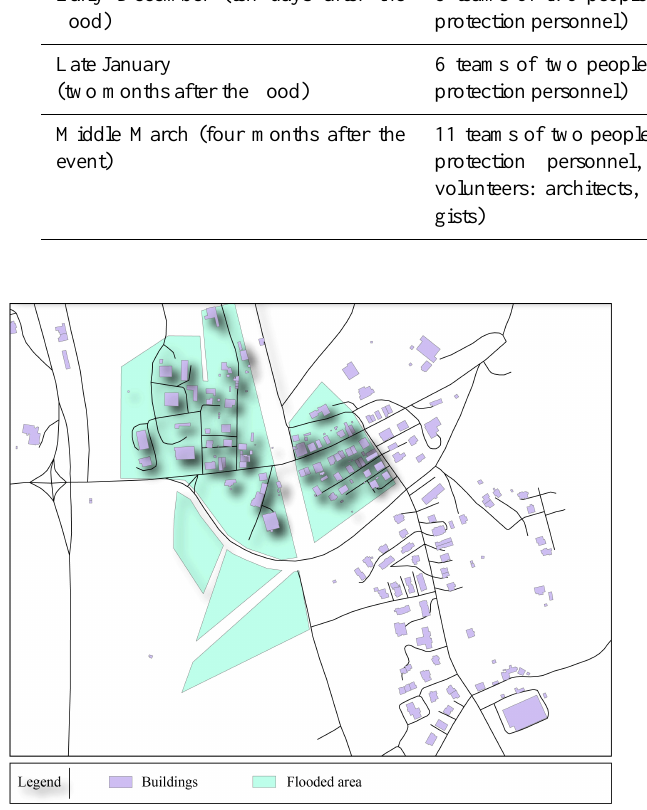
Fig. 2. Flood zone in the Ponticelli area, Città della